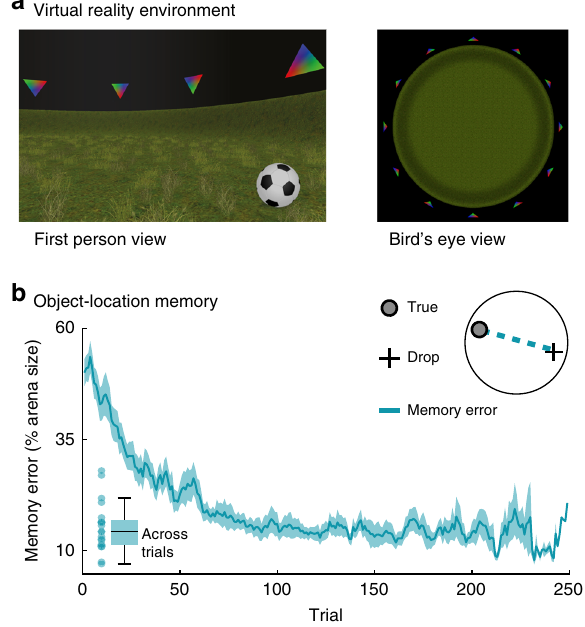
Fig. 1 Spatial memory task in virtual reality (VR). a First-person and bird ’ s-eye view of the VR environment in which participants navigated freely via key presses. The circular arena was surrounded by 12 landmarks matched in visual features (colored triangles). Across trials, participants memorized and reported object locations by navigating to them and pressing a “ drop ” button followed by feedback. b Object-location memory. Participants ’ memory performance improved as indicated by a decrease in memory error (Euclidean distance between drop and true location). The blue line and shaded area represent the mean and SEM of the memory error across participants. Data were smoothed with a moving average kernel of fi ve trials. The inset on the bottom left depicts the median memory error across trials for single participants and as whisker – boxplot (center, median; box, 25th to 75th percentiles; whiskers, 1.5× interquartile range, n = 20 participants). Source data are provided as a Source Data fi